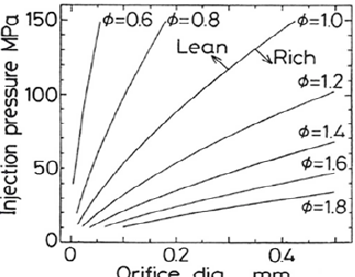
Figure 28. Effect of nozzle orifice diameter and injection pressure on mean equivalence ratio at 0.8 ms after start of injection [37].